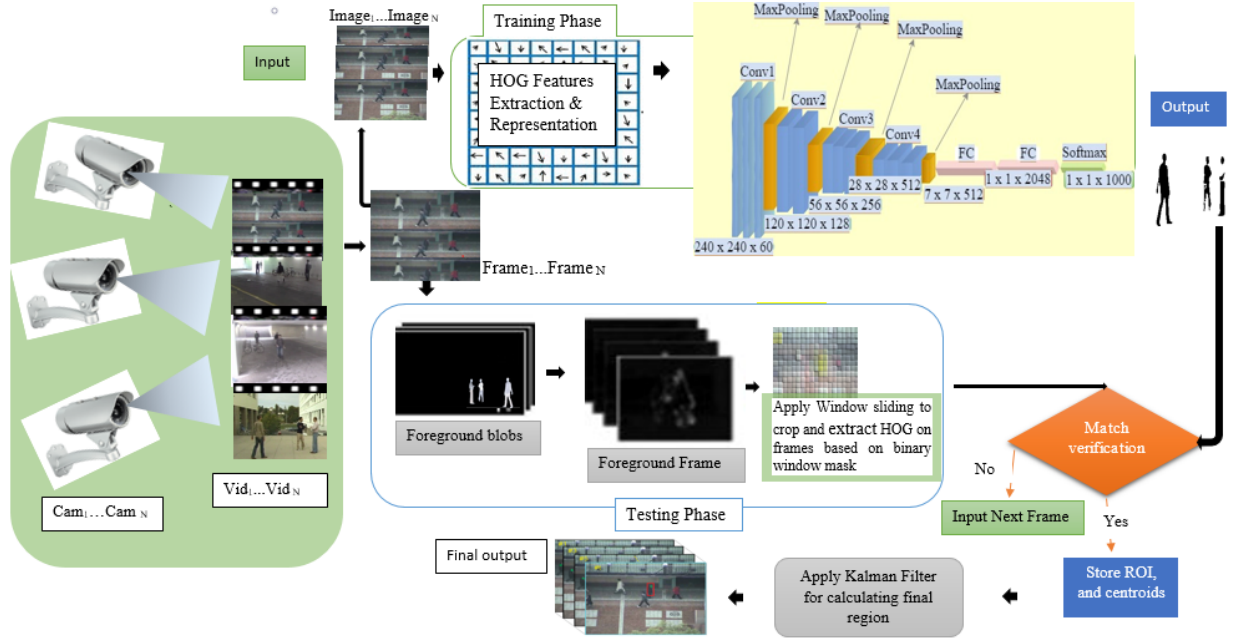
Figure 1. Proposed HCNN method implementation architecture overview.